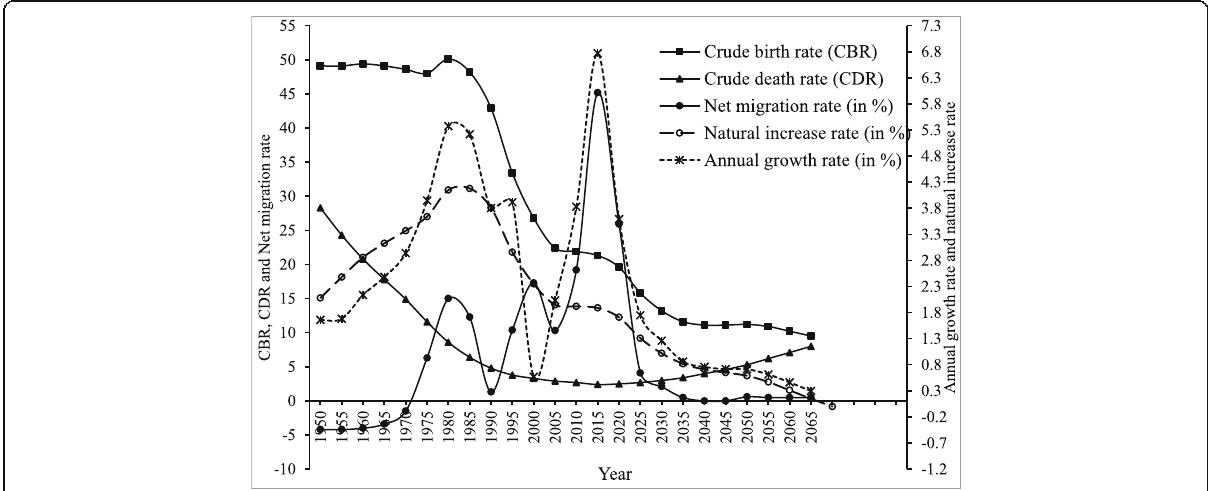
Fig. 1 Trends in annual population growth rate (in %), rate of natural increase, crude birth rate (CBR), crude death rate (CDR), and net migration rate: Oman 1950 – 2065. Source: UN population estimates and projection